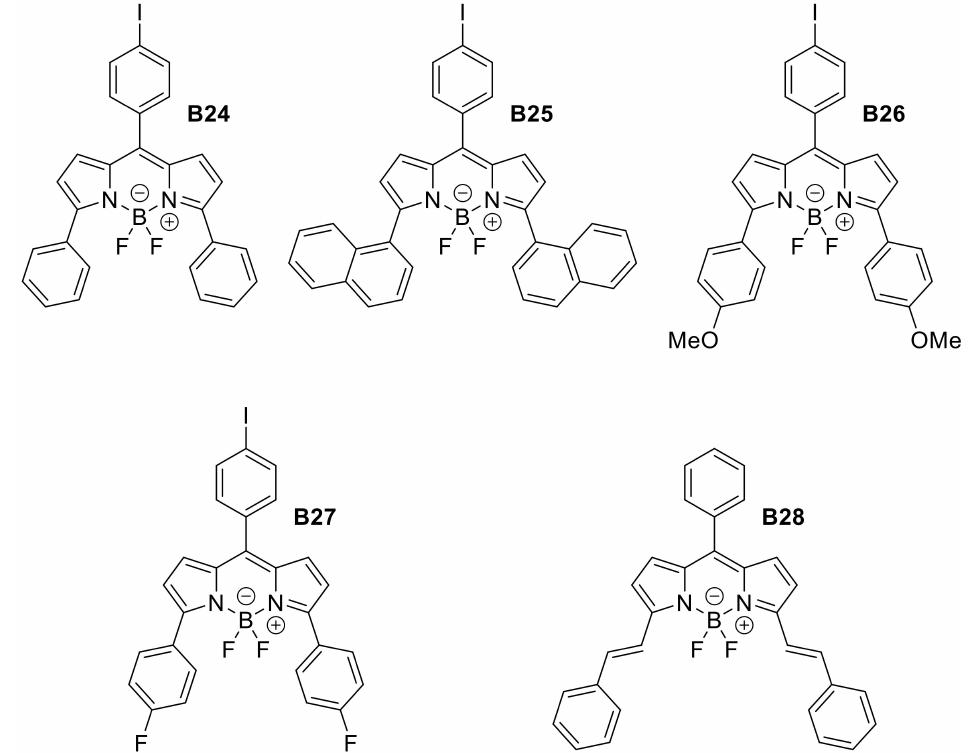
Figure A6. Aromatic groups placed at the meso and α